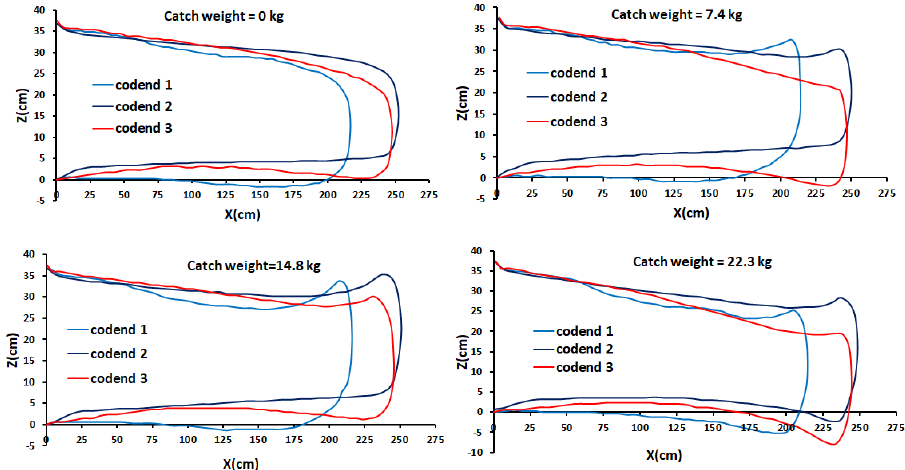
Figure 12. Geometrical profile of the three codends obtained from video cameras at catch weight ( 𝑢 (cid:2868) = 0.9 m/s).